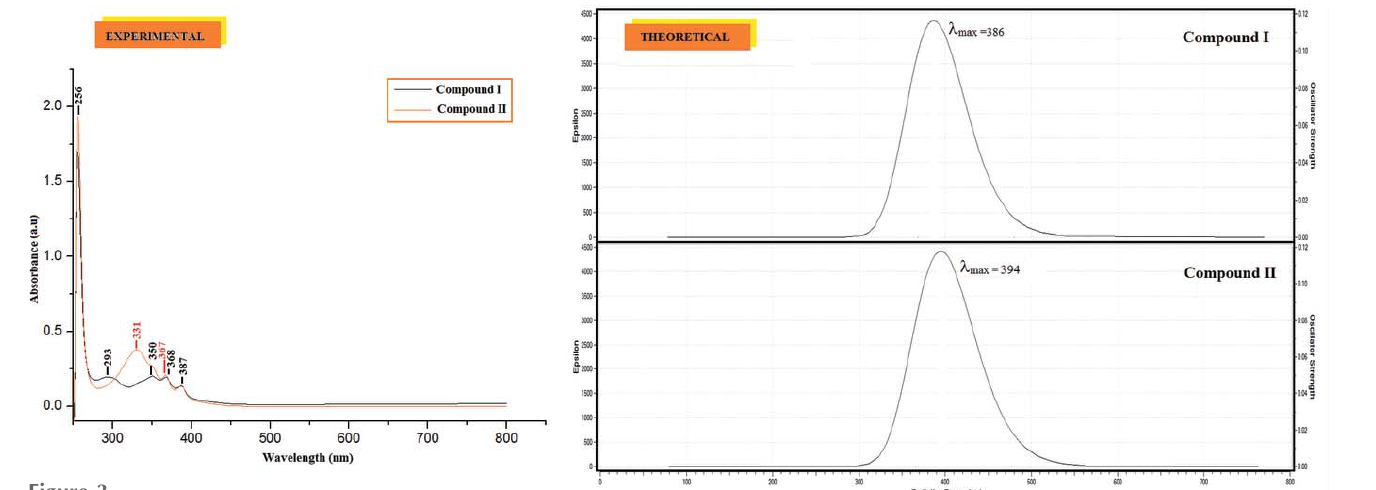
Figure 3 UV–Vis absorption spectra of compounds (I) and